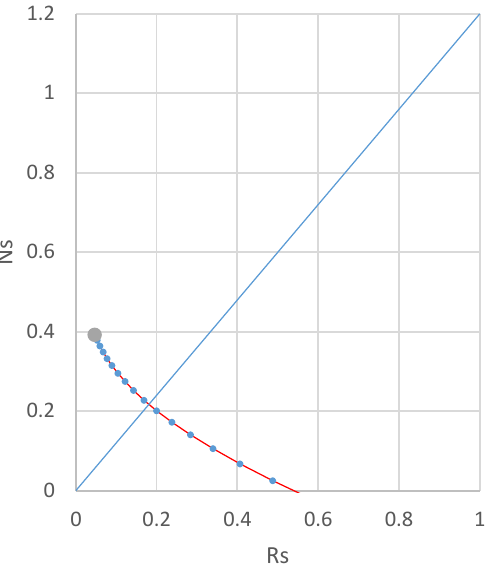
Figure 4. Feature space plot of R s and N s for varying LAIs. The grey dot indicates the point where the assumed LAI = 0. The blue-coloured straight line is the locus of all points where N s / R s = S = 1.2. from the intersection of one red line segment with the blue line. Next, the soil’s